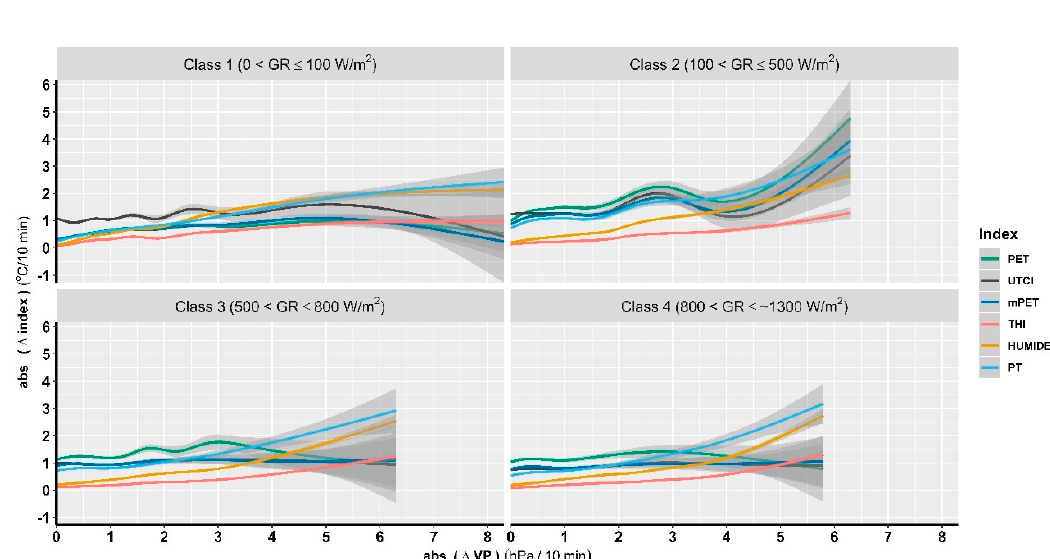
Table 11. Descriptive statistics of the indices’ sensitivity to Vapour Pressure (VP) change rates under different Global Radiation (GR) conditions.